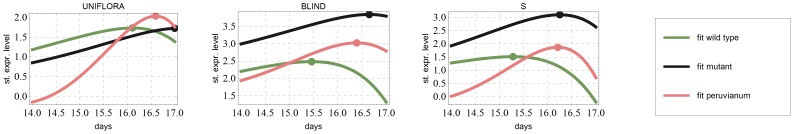
Time delay in expression peaks.The early genes UF and BL as well as the central hub in the network, the S-gene, are plotted, zooming in to the region where the expression levels reach their maximum. Expression levels peak first in the wild type S. lycopersicum, secondly in S. peruvianum and as last in s mutant. The points corresponding to maximal value are represented with dots. This result is in line with the findings of Park et al. on the chronological order of apical meristem maturation in the three genotypes.